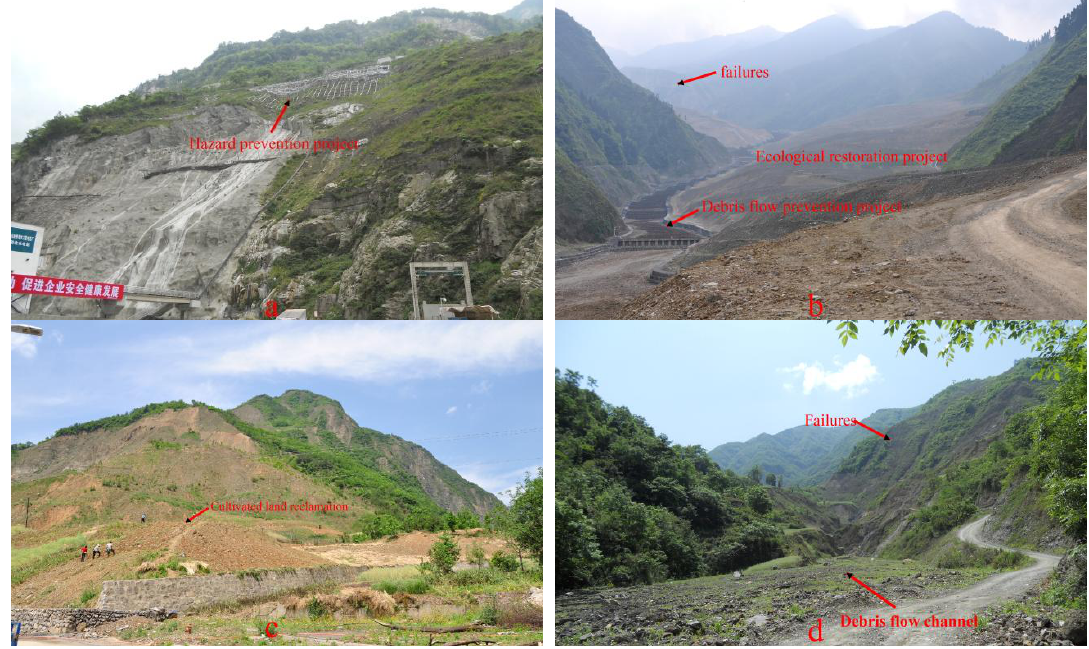
Figure 9. ( a ) Hazard prevention project in Yingxiu Town, Wenchuan County (site No. 7); ( b ) Human activity in Wenjiagou, Qingping Town (site No. 1); ( c ) Reclamation on the landslide mass in Chenjiaba, Mianzhu City (site No. 4); ( d ) Natural vegetation recovery in Chenjiaba, Mianzhu City (site No.